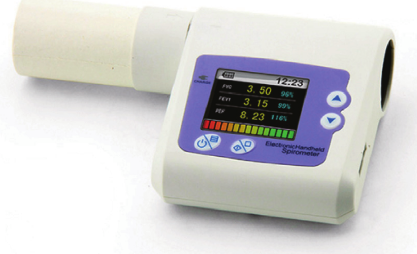
Figure 4: An example of crossover operation. The crossover op- eration for individual a k and a l performs at the j position. Part of the chromosome information has been exchanged for a k and a l .